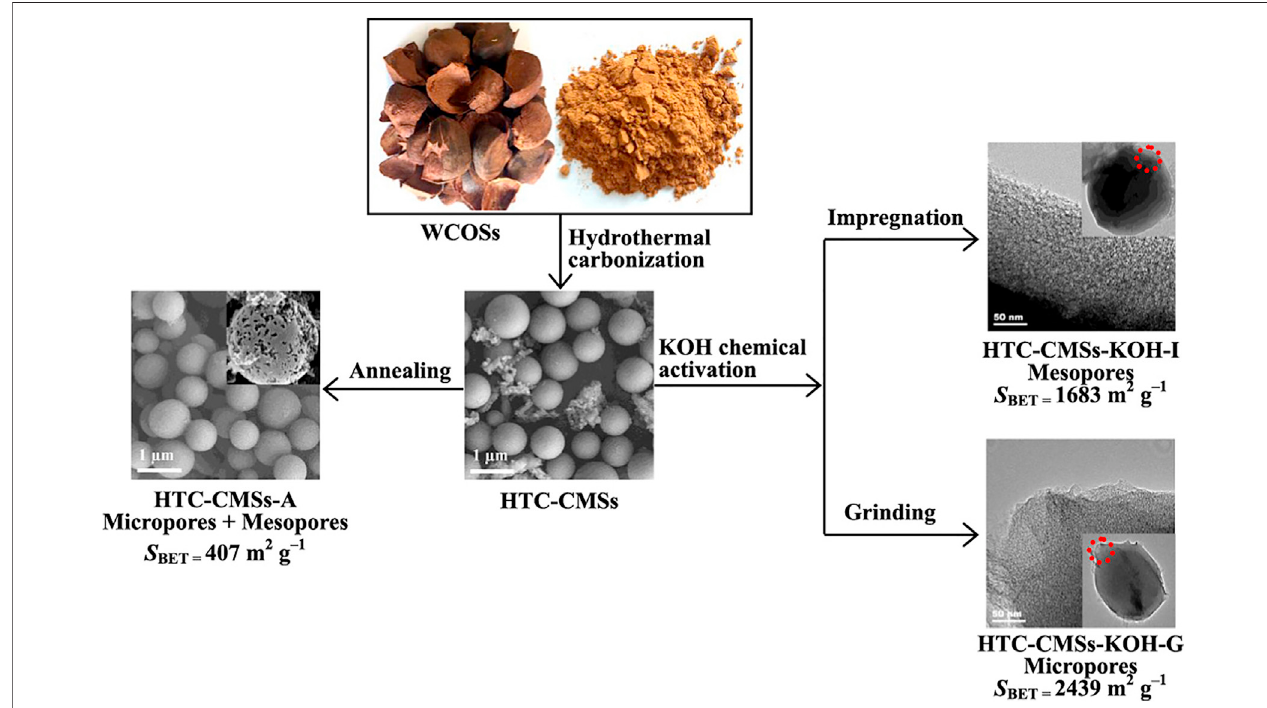
FIGURE 5 | Porous carbon microspheres made from camellia shells by KOH chemical activation. Copyright 2016